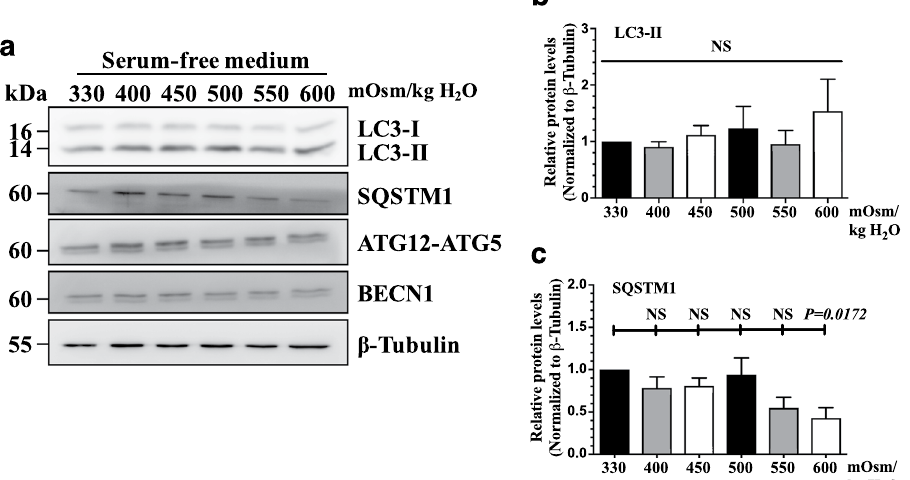
Figure 4. Serum withdrawal does not modulate the effect of hyperosmolarity on autophagy in NP cells. ( a ) Western blot analysis of NP cells cultured in serum-free media with increasing osmolarity (330–600 mOsm/ kg H 2 O) showed that the levels of autophagic markers including LC3-II, ATG12-ATG5, and BECN1 were unaltered. SQSTM1 levels did not change with increasing osmolarity except for a small decrease at 600 mOsm/ kg H 2 O. ( b , c ) Densitometric analyses of multiple Western blots. Bars represent mean ± SEM (n = 5). One- way ANOVA with Sidak’s multiple comparisons test was used to determine statistical significance. NS, non-significant. Western blot images were cropped and acquired under same experimental conditions. See Supplementary Fig. S1 for examples of uncropped